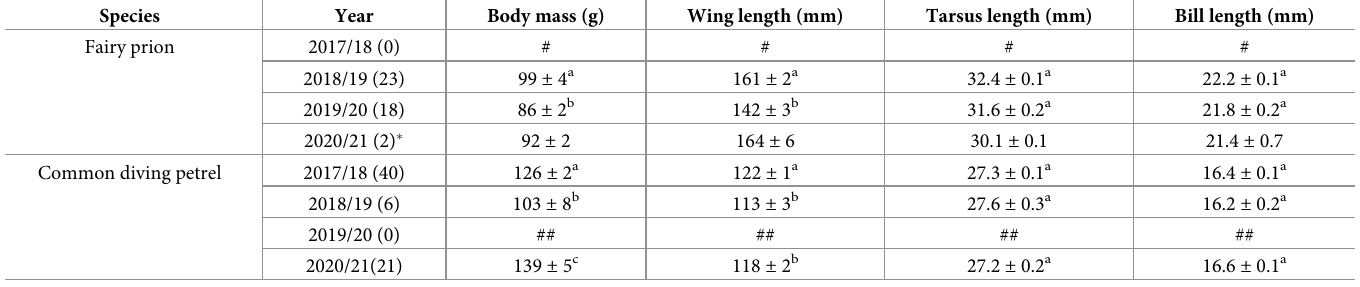
The SST in Bass Strait during summer preceding the breeding season of FP and CDP varied significantly between years (Dec-Feb; ANOVA: F = 94.321, P < 0.001) and in the post- 10 . 976 breeding migration area of CDP (Fig 4; ANOVA: F = 18.803, P = 0.011). In Bass Strait, 3 . 792 SST in the summers preceding the 2018/19 and 2019/20 breeding seasons was 2–4˚C warmer than prior to the 2017/18 and 2020/21 breeding seasons. During this period, SST in Bass Strait was > 1˚C above the climatologic average for 95 consecutive days in 2018/19, and 68 consecu- tive days in 2019/20, while it was only four consecutive days above the average in 2017/18 and 0 in 2020/21, delineating 2018/19 and 2019/20 as years of MHW. Accordingly, the GLMM results indicated a strong negative effect of SST on the phenology for FP (S1-S3 Tables in S1 File) and both breeding success and phenology for CDP (S4-S6 Tables in S1 File).